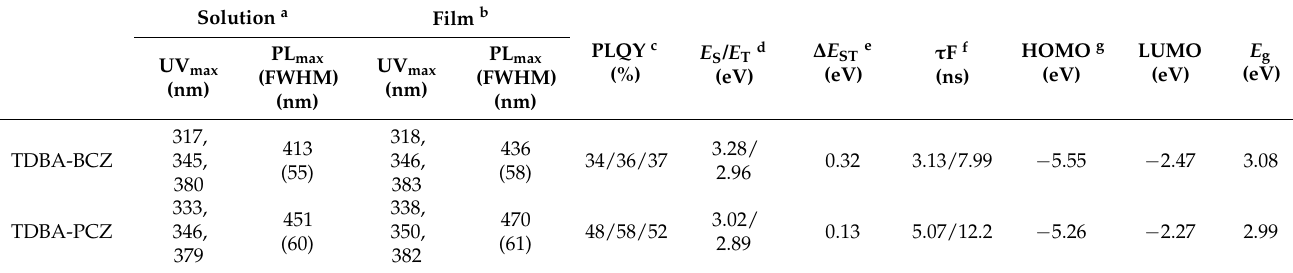
Table 1. Photophysical properties of the synthesized